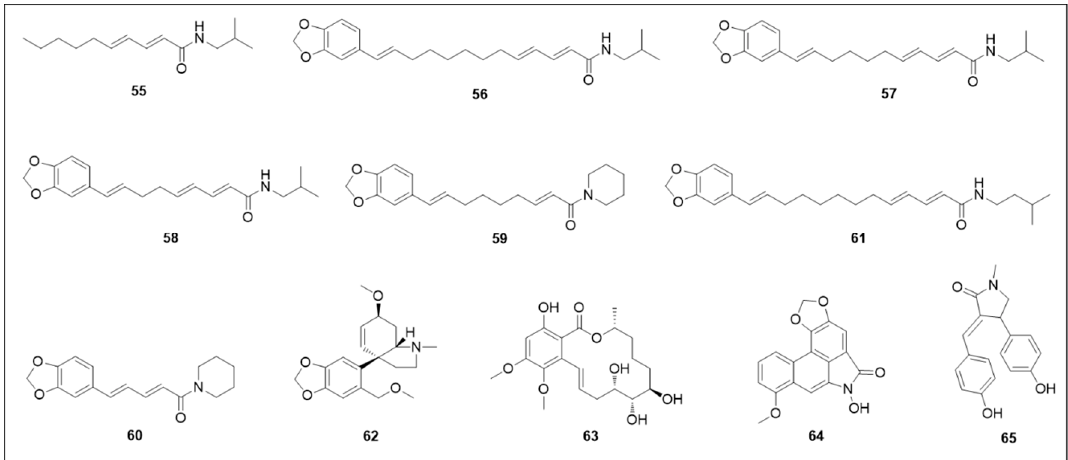
Figure 9. Alkaloids and amides active against Ae. aegypti .